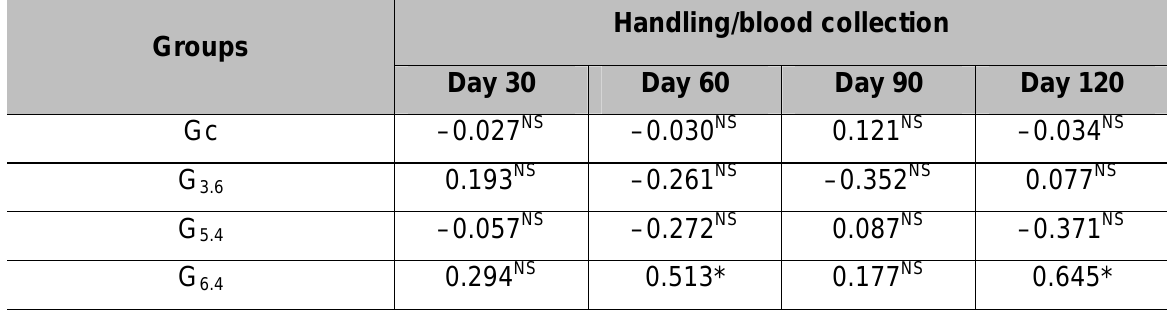
Table 1. Spearman’s correlation coefficient (R) for serum cortisol levels and rabies antibody